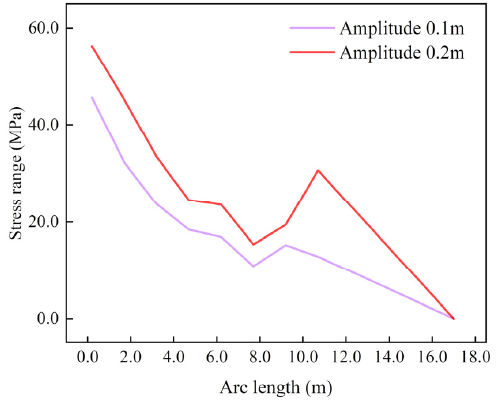
Figure 33. Out-of-plane stress range distribution along SCR.